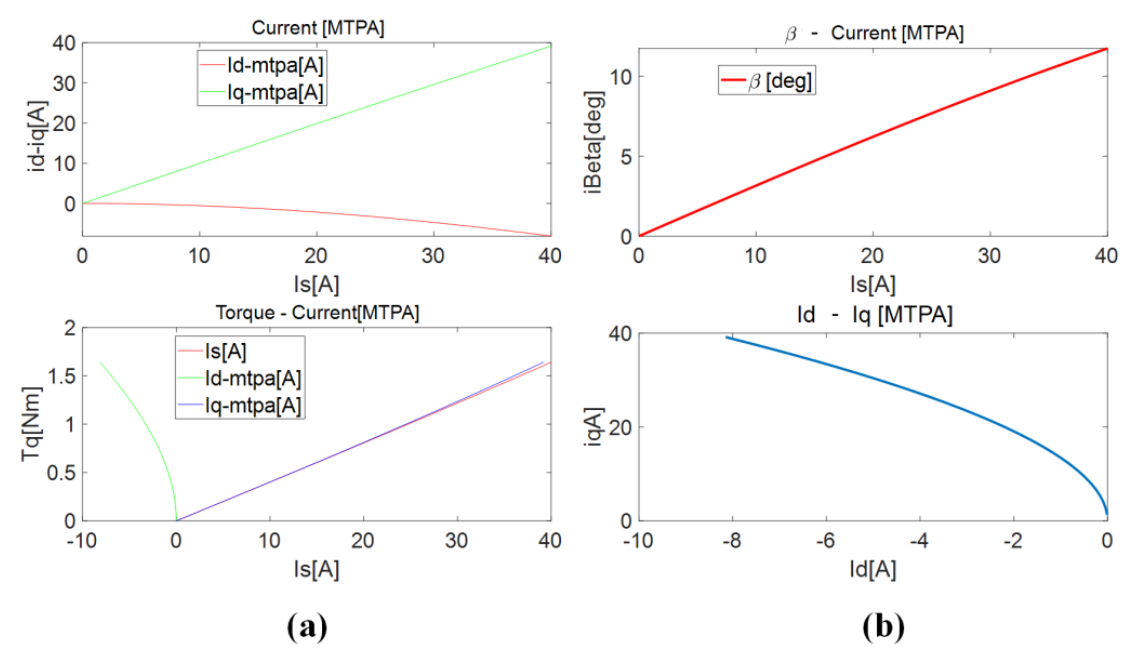
Figure 5. Current according to torque and current phase angle of IPMSM: ( a ) current and torque according to MTPA control and ( b ) current phase angle characteristic according to I s .